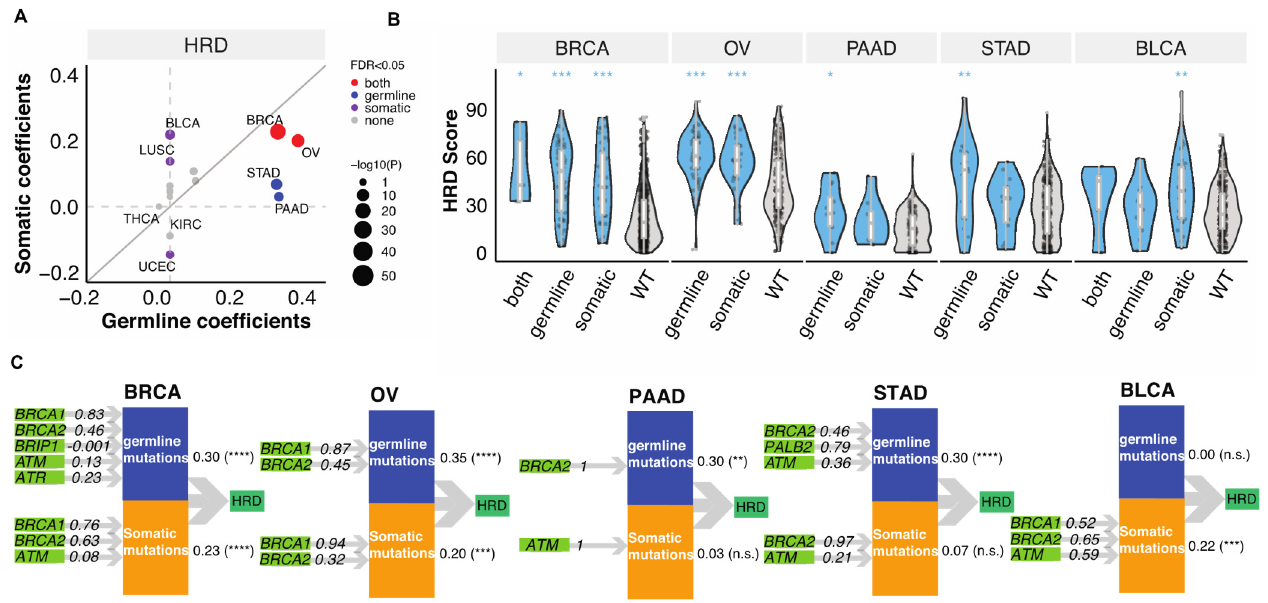
Figure 2. The combined contributions of germline variants and somatic mutations to HRD. ( A ). The combined germline and somatic contributions represented by coefficients obtained from the PLS-PM analysis. Each dot represents a cancer type. The size of the circles represents − log10( p ). Grey, purple, blue, and red represent none of, somatic, germline, or both FDR meet the criteria FDR < 0.05. The grey line indicates the diagonal with slope of one. ( B ). The distribution of HRD score in combined germline and somatic carriers in BRCA ( n = 5 (both), 53 (germline), 38 (somatic), 850 (wildtype)), OV ( n = 66 (germline), 31 (somatic), 272 (wildtype)), PAAD ( n = 12 (germline), 8 (somatic), 131 (wildtype)), STAD ( n = 18 (germline), 15 (somatic), 309 (wildtype)), BLCA ( n = 5 (both), 10 (germline), 32 (somatic), 334 (wildtype)). p -value was calculated using a two-sided Mann–Whitney test and FDR corrected. “***”, “**”, “*” denote FDR less than 0.0001, 0.001, and 0.05. ( C ). PLS-PM models show the significant combined contribution of germline variants and somatic mutations with FDR < 0.05 of combined effect in selected cancer types, including BRCA, OV, PAAD, STAD, and BLCA. The numbers between the latent variables and HRD indicated combined correlation coefficients identified by the PM-PLS model, the value. “****”, “***”, “**”, denote FDR less than 0.00001, 0.0001, and 0.001. “n.s.” denotes “not significant” (FDR >